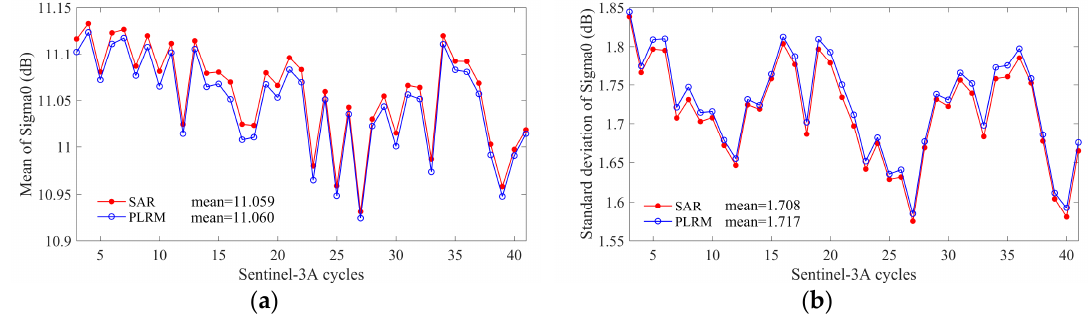
Figure 12. Cycle by cycle ( a ) means and ( b ) standard deviations of backscattering coefficients according to Sentinel-3A repeat cycles.